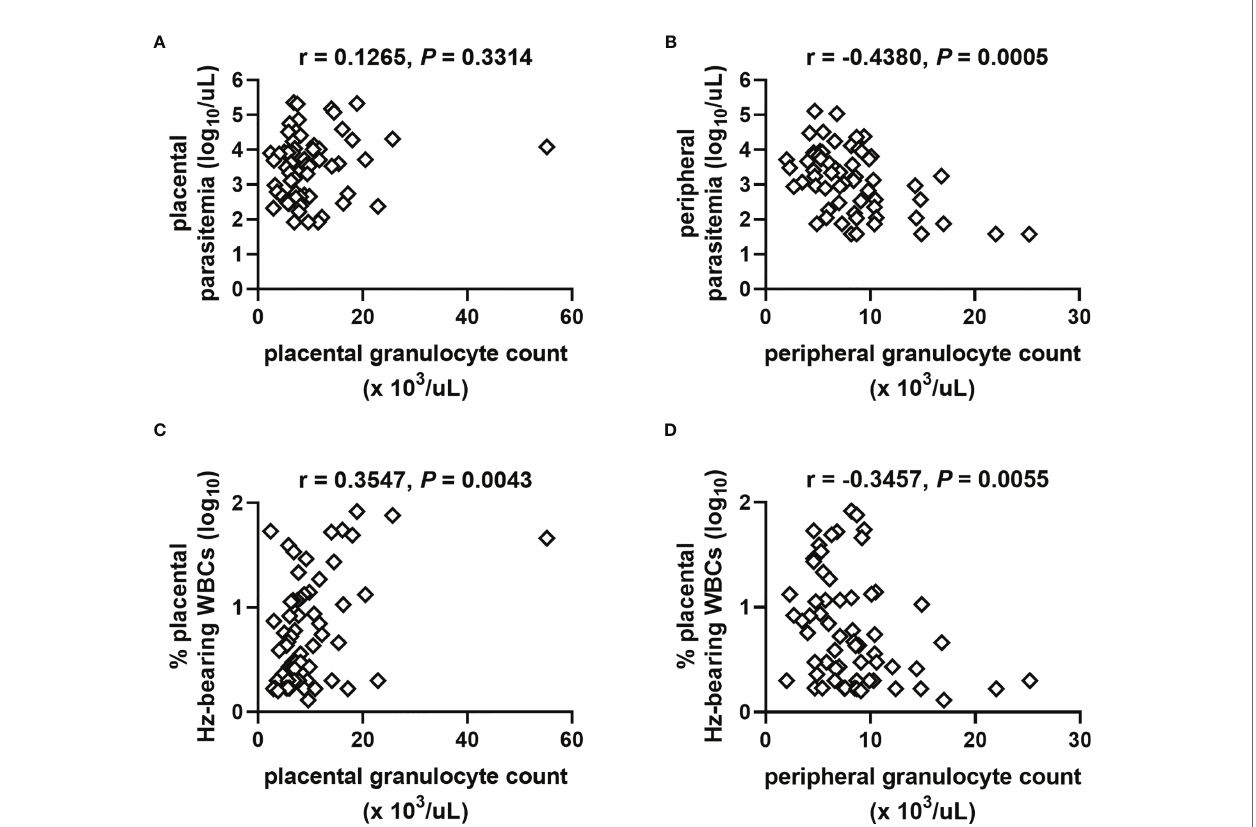
FIGURE 3 | Relationships of granulocyte numbers with measures of placental malaria vary as a function of blood source. Placental granulocyte counts measured by complete blood count in women with PM are unrelated to (A) placental parasite density but positively correlate with (C) the level of Hz-bearing WBCs in the placental intervillous space. Peripheral granulocyte counts negatively correlate with (B) peripheral parasite density and (D) level of Hz-bearing WBCs in the placental intervillous space. Both infection measures are log transformed. Results of Spearman ’ s correlation analysis are shown. (A, B) n = 61; (C, D) n =